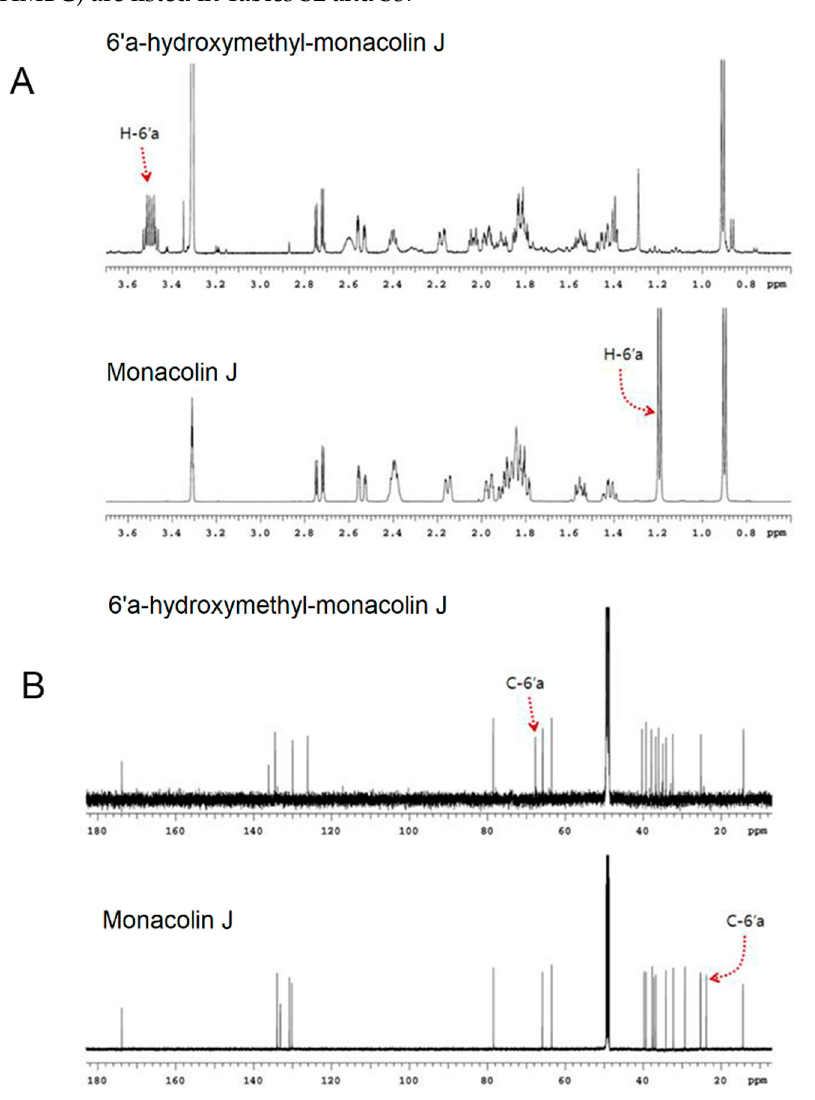
Figure 5. NMR results of the major product of monacolin J when using CYP102A1. ( A ) Expanded 1 H NMR spectra of monacolin J and its product, namely, 6 ′ a-hydroxymethyl monacolin J (0.7~3.7 ppm region). Chemical shift of methyl protons at C-6 ′ a of monacolin J moved downfield at 3.50 ppm. ( B ) 13 C NMR spectra of monacolin J and its product, namely, 6 ′ a-hydroxymethyl monacolin J.